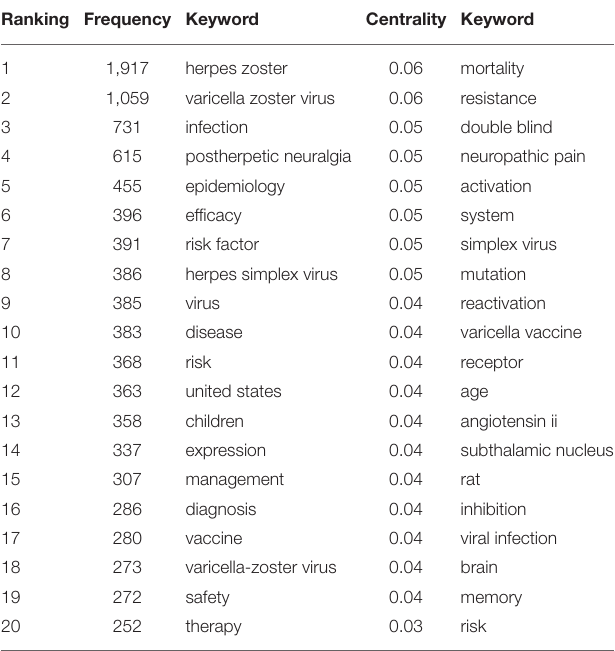
TABLE 6 | Top 20 keywords in terms of frequency and centrality in Herpes zoster